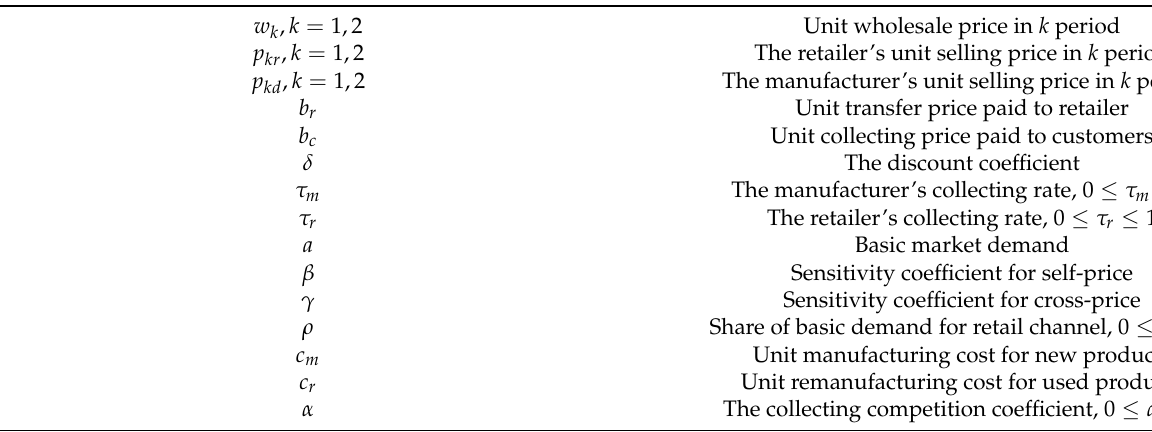
Figure 3. Three dual-channel CLSC models. Table 2. Parameters and definitions.